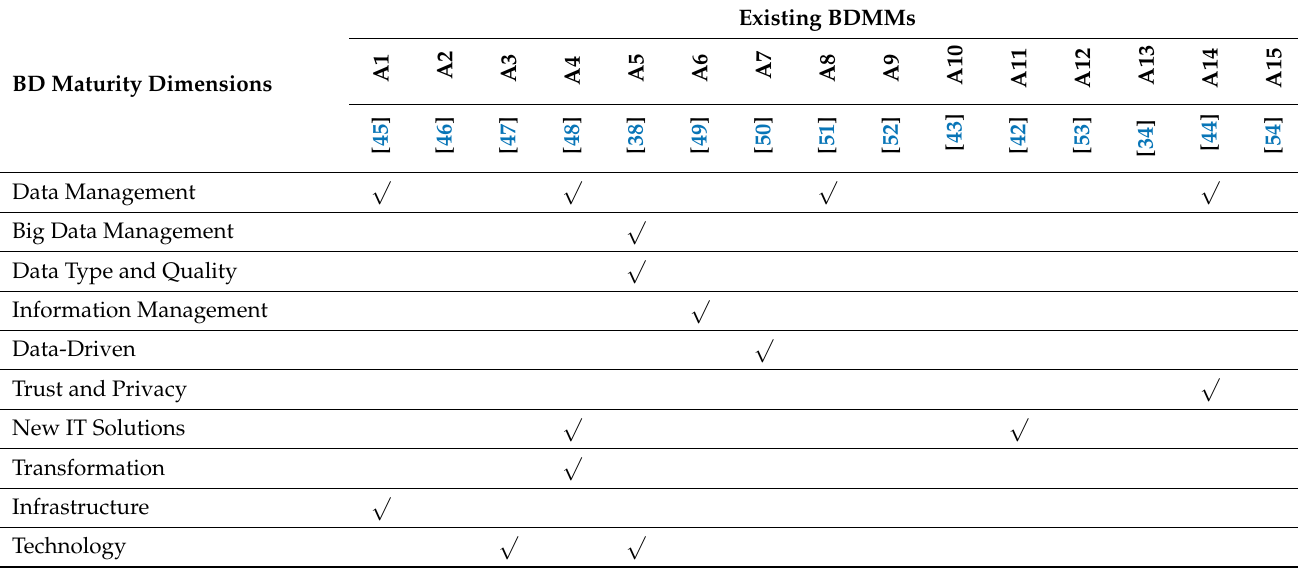
Table 8. The dimensions of Big Data maturity and the respective